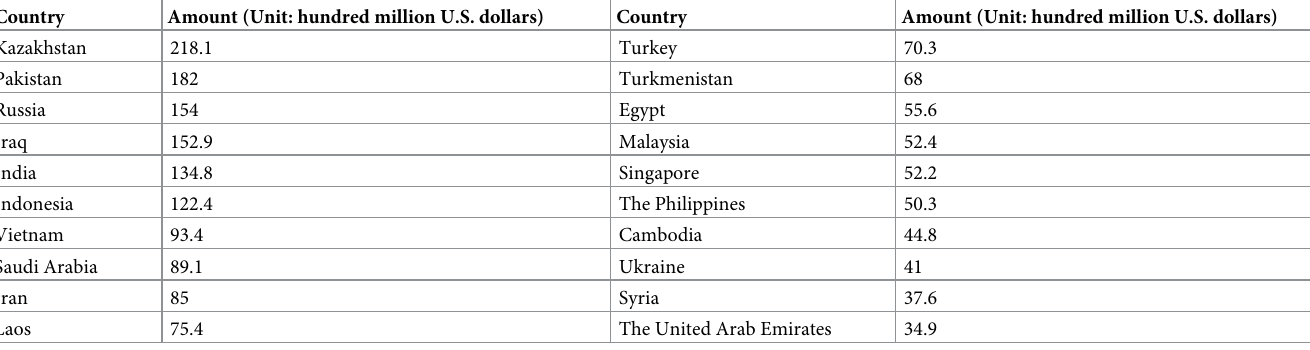
Table 1. Investment by Chinese energy companies in “B&R” countries from 2005 to 2014. Country Amount (Unit: hundred million U.S. dollars)